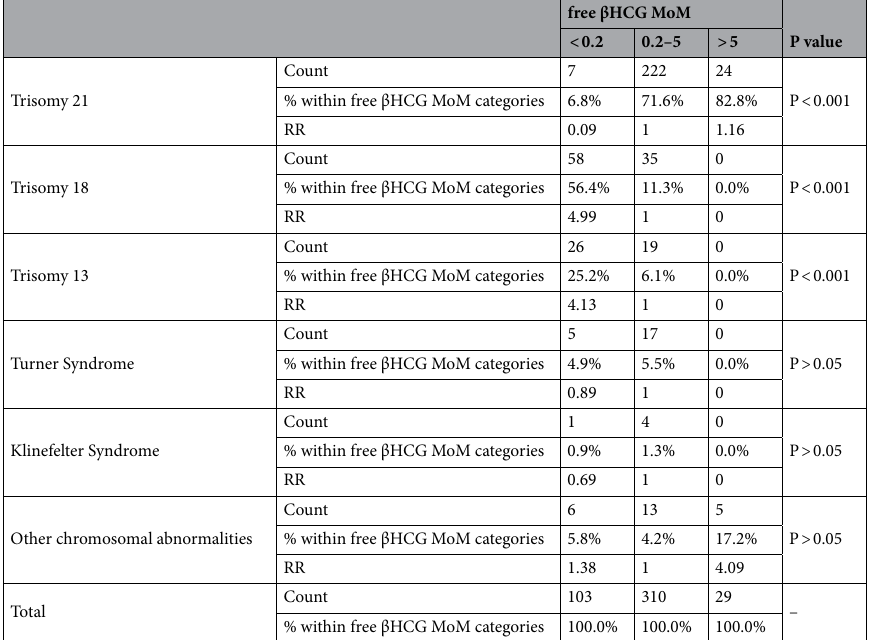
Table 2. Frequency of chromosomal abnormalities in different groups of patients based on the levels of free βHCG MoM (RR, relative